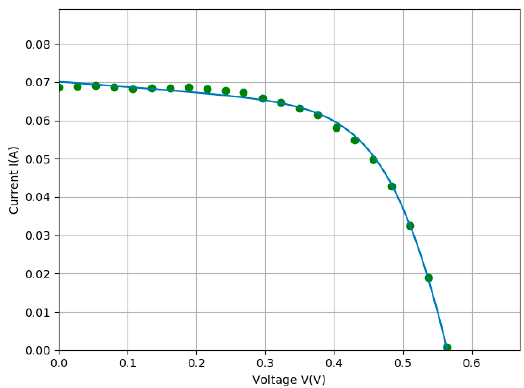
Figure 6. Comparison between experimental data (green dots) and the algorithm calculated I–V curve (blue line) for the FSTT solar cell.